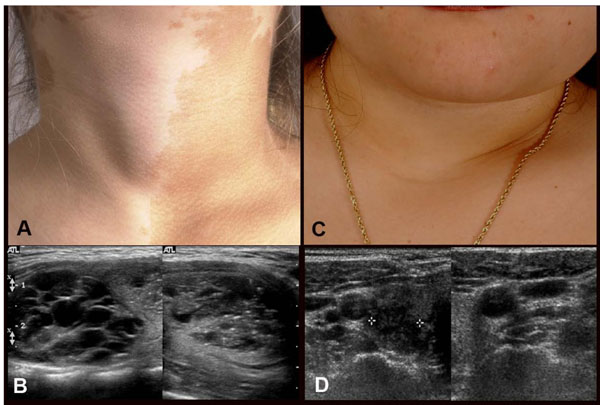
Clinical and ultrasound findings of thyroid involvement in FD/MAS. Panels A & B demonstrate the findings in a 9-year-old girl with MAS and hyperthyroidism. A goiter is clearly seen on inspection (A) and the ultrasound (B) shows the typical cystic (Swiss cheese) appearance that seen in MAS thyroids. Panels C & D demonstrate the findings of a 30-year-old woman with MAS. While no goiter was evident on inspection, nor was one obvious on palpation, the ultrasound clearly demonstrated the typical findings seen in ultrasounds of patients with MAS and thyroid involvement. Adapted from reference [13.]